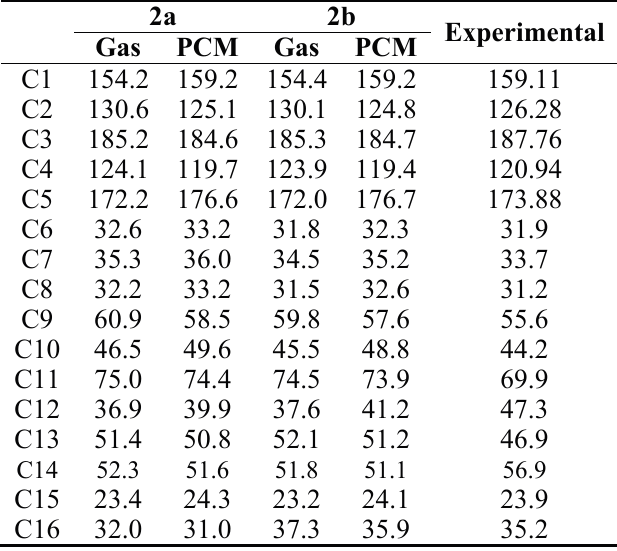
Table 3. Experimental and predicted 13 C-NMR chemical shifts ( δ ppm) of stereoisomers 2a and 2b obtained at the B3LYP/6–31+G(d,p) level of